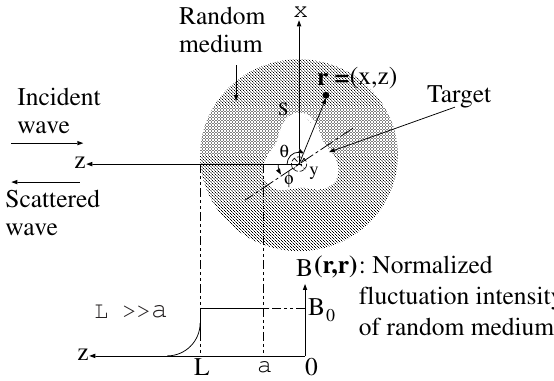
Figure 1. Problem geometry of waves scattering from a conducting cylindrical object in a disordered